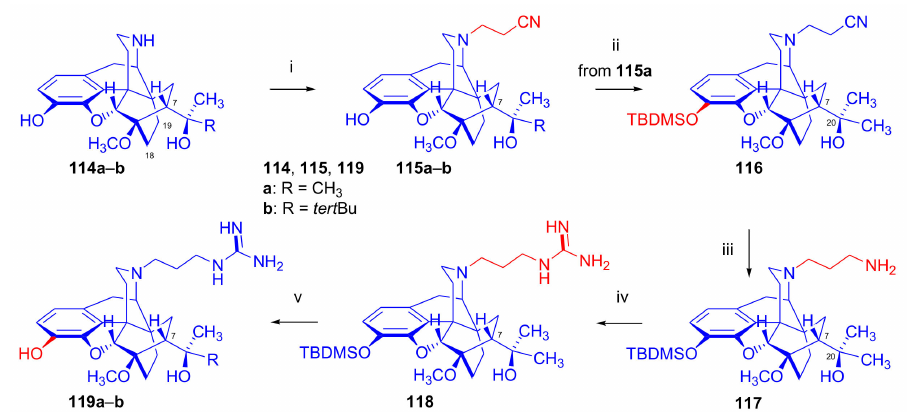
Figure 36. Synthesis of N 17 -[3-(2-carboxamidino)-amionopropyl]-nordiprenorphine and - norbuprenorphine. Reagents and conditions : (i): 3.5 equiv. acrylonitrile, EtOH, room temperature, overnight, 62%; (ii): TBDMSCl, imidazole, DMAP, DMF, room temperature, 2 h, 89%; (iii): LiAlH 4 , Et 2 O, room temperature, 4 h, 78%; (iv): 1 H -pyrazole-1-carboxamidine hydrochloride, DIPEA,